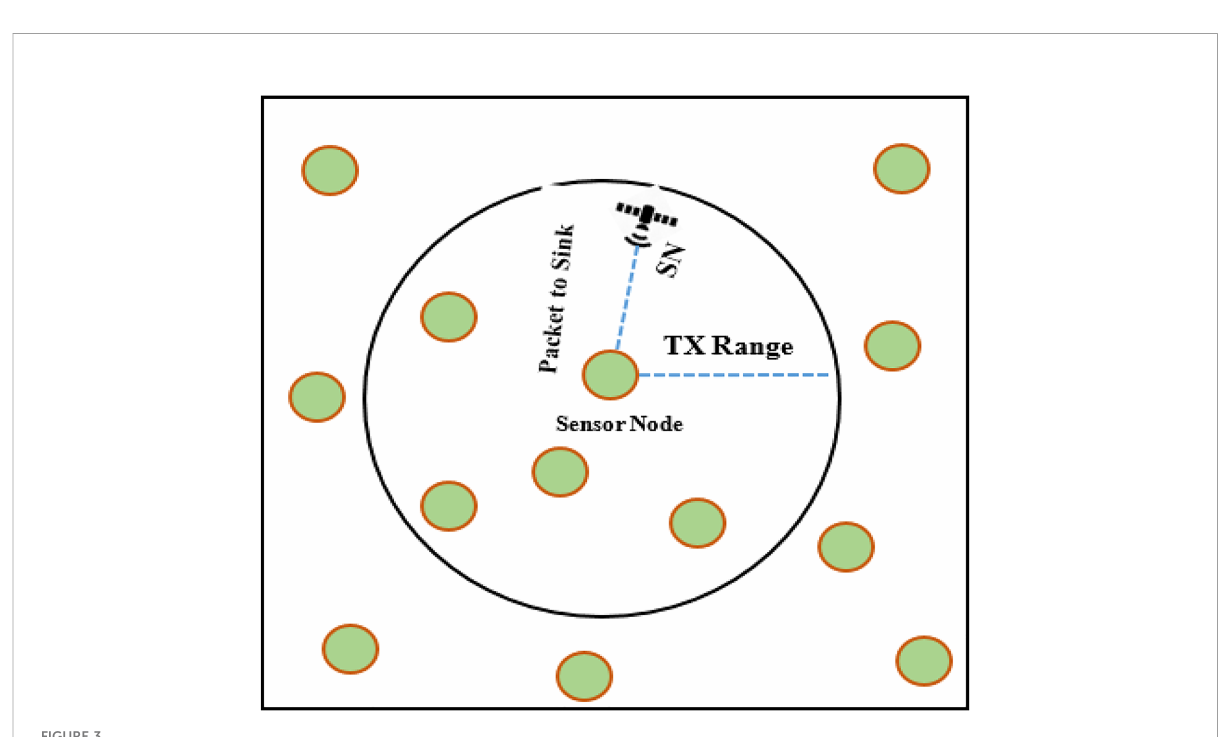
FIGURE 3 Direct Packet transmission